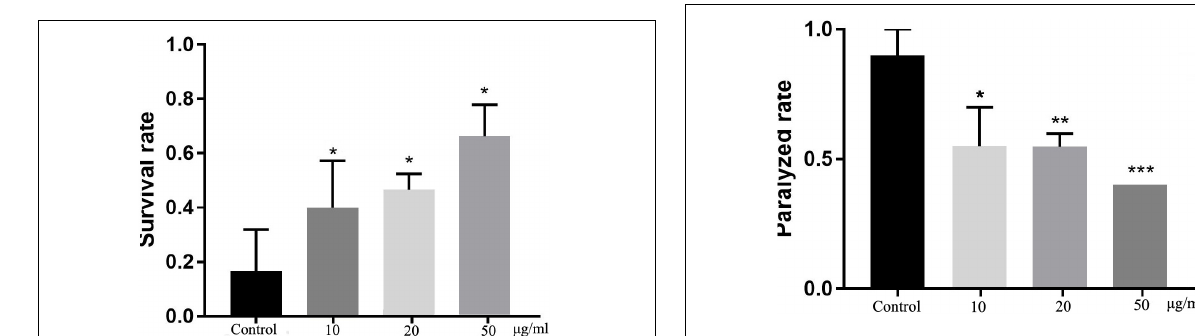
FIGURE 4 | Effects of TFH on oxidative stress tolerance of C. elegans . Three replicates were used per treatment. Differences compared to control group were considered significant at * p ≤ 0.05.